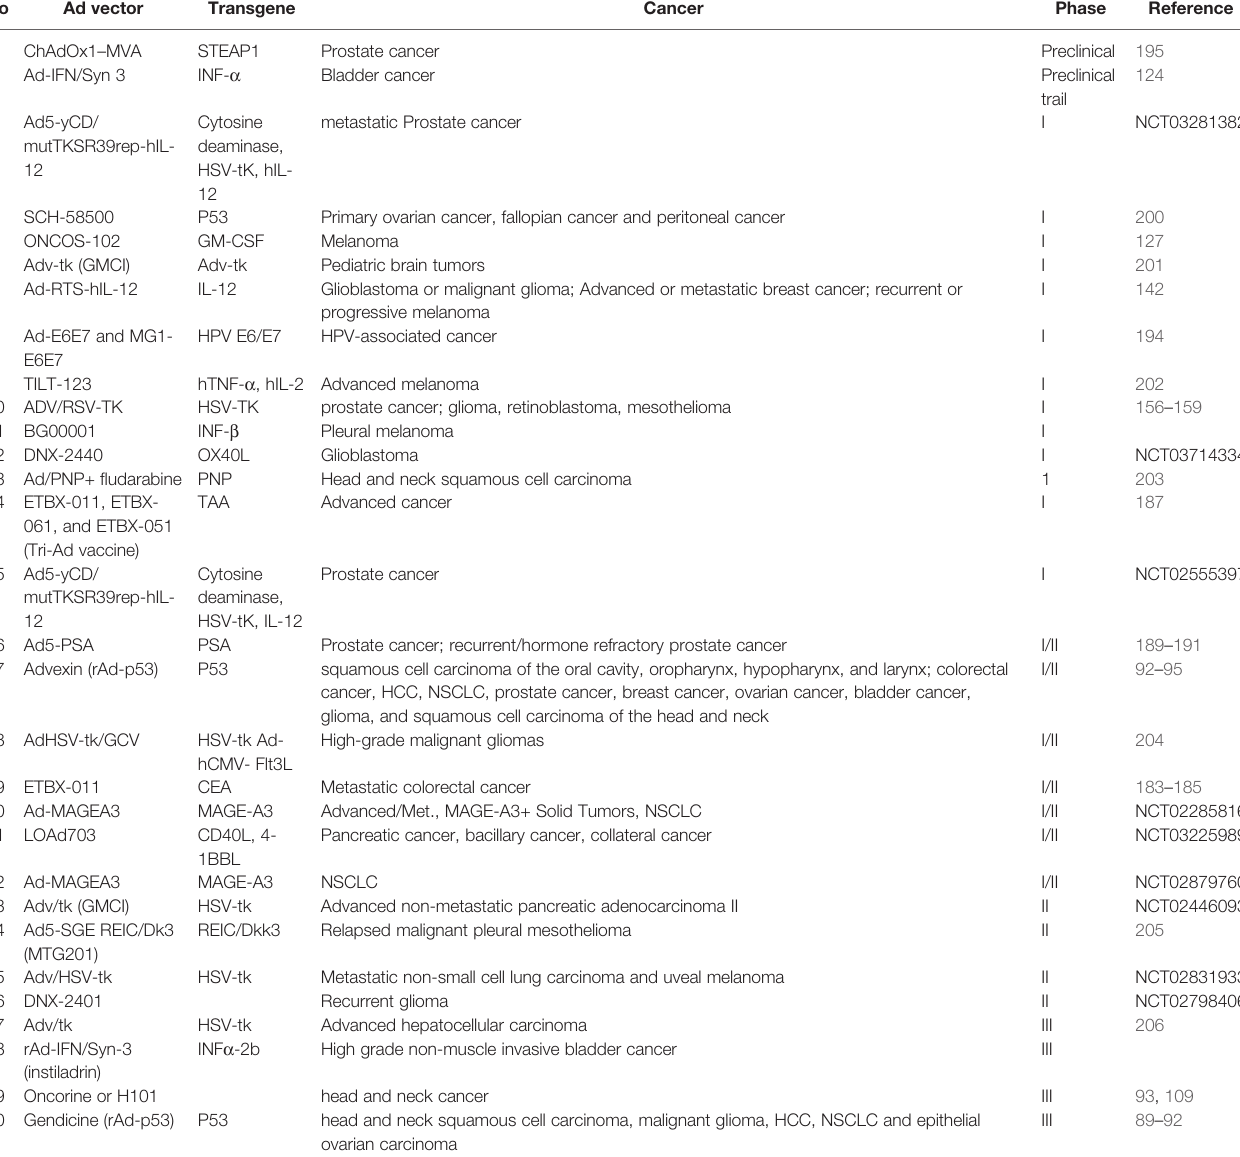
TABLE 1 | Clinical trials using replicating and non-replicating adenoviral vectors for cancer